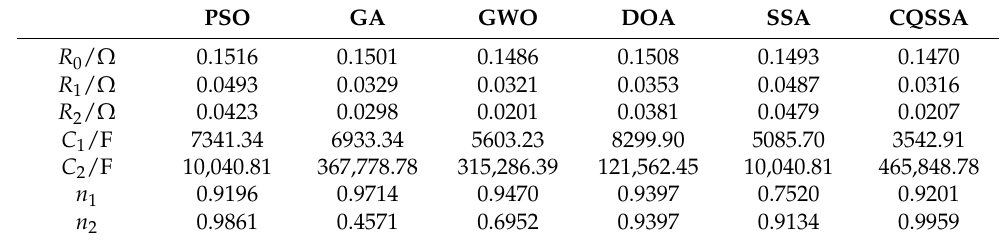
Table 5. Model parameter identification results of six optimization algorithms under HPPC test.